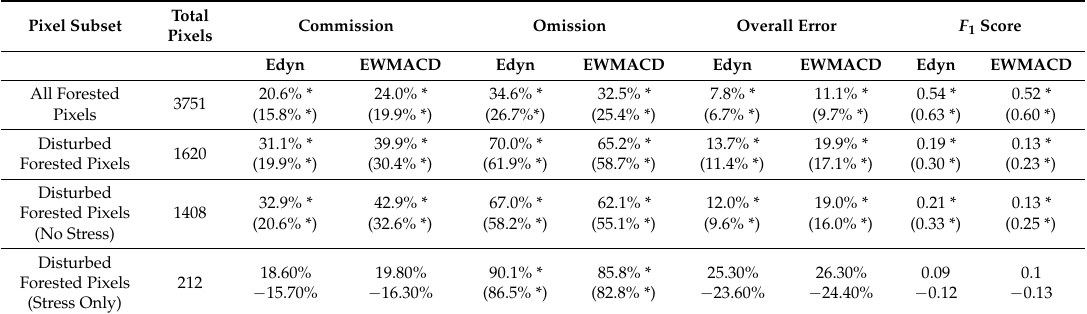
Table 2. Mean error rates and F 1 scores for Edyn and EWMACD outputs compared as time series against various subsets of the TimeSync reference data. Mean error rates when allowing a one-year offset are given in parentheses below the associated results. Pairings with significantly different mean error rates are marked by an